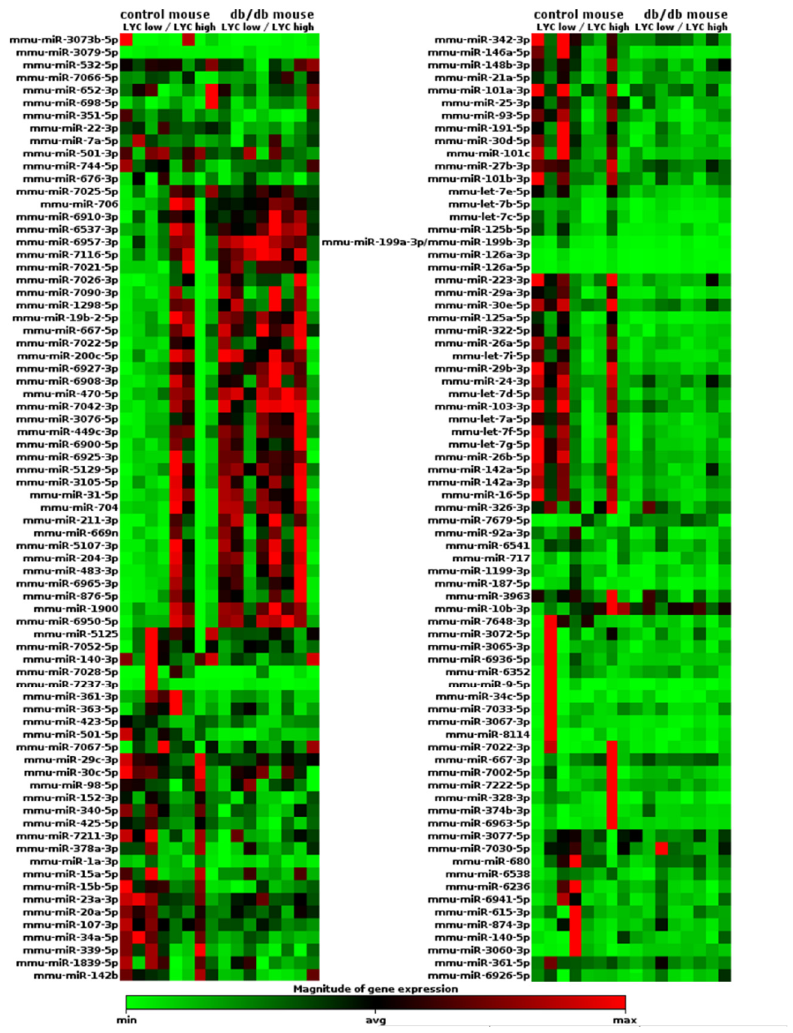
Figure 4. Heat map of miRNA expression data obtained with NGS from two populations of cardiac macrophages isolated from control ( n = 4) and db/db ( n = 4) mouse hearts. Results were normalized with the “Trimmed Mean of M” method and heat map was prepared on the basis of geNorm method. Relative miRNA expression is depicted according to the color scale shown below. Red indicates upregulation; green,